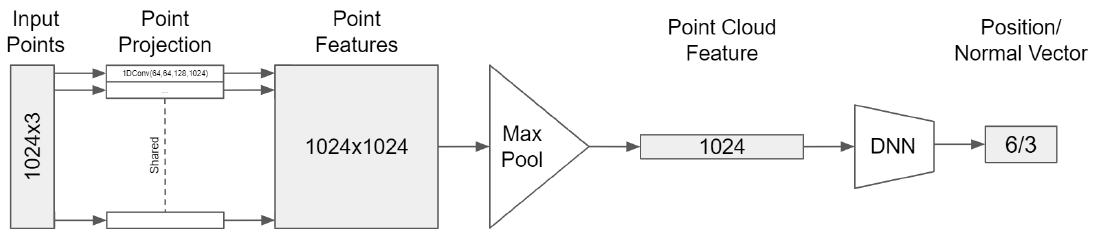
Figure 11. Cutting pose regression network based on